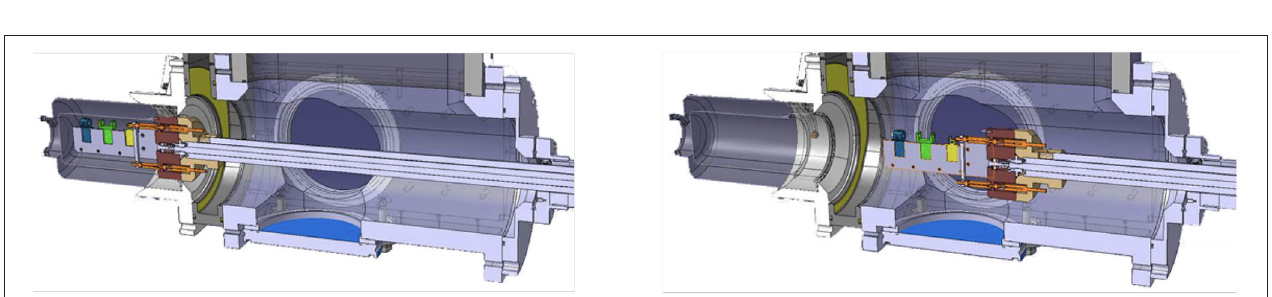
FIGURE 3 | Sample holder positioning. Three different sample positions are shown (blue, green, and yellow). A vacuum valve separates the sample container from the collection box. Once the container is attached to the collection box, the valve is opened, the samples moved into the collection box, and the vacuum valve is closed. Fresh samples to be placed at irradiation position (Left) and samples in position to be irradiated, docked in the transport box (Right)